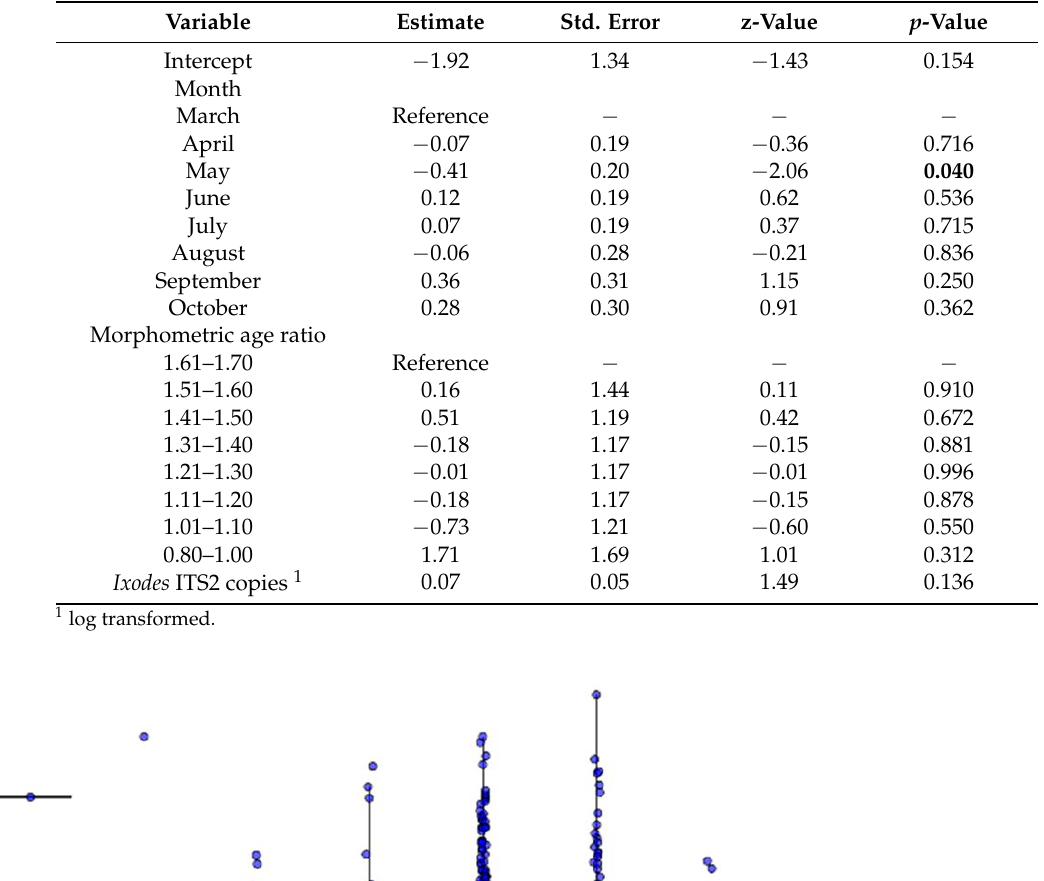
Table 4. Results of the binomial GLMM investigating the effect of tick morphometric age, sampling month, and Ixodes ITS2 copy numbers on Borrelia spp. prevalence. The full model was significantly different from a null model containing only the random factor ( χ 2 = 27.13, Df = 15, p = 0.028). Significant p -values ( ≤ 0.050) are shown in bold.